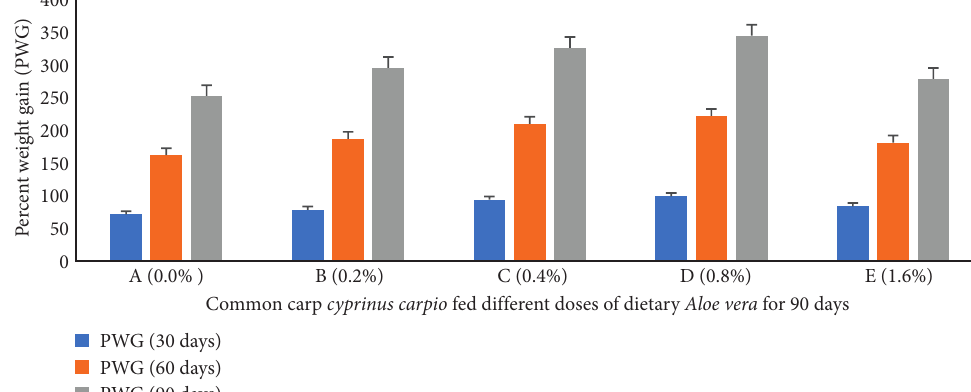
Figure 1: Cyprinus carpio fed varied doses of Aloe vera and percent weight gain (PWG) studied after 90 days of feeding